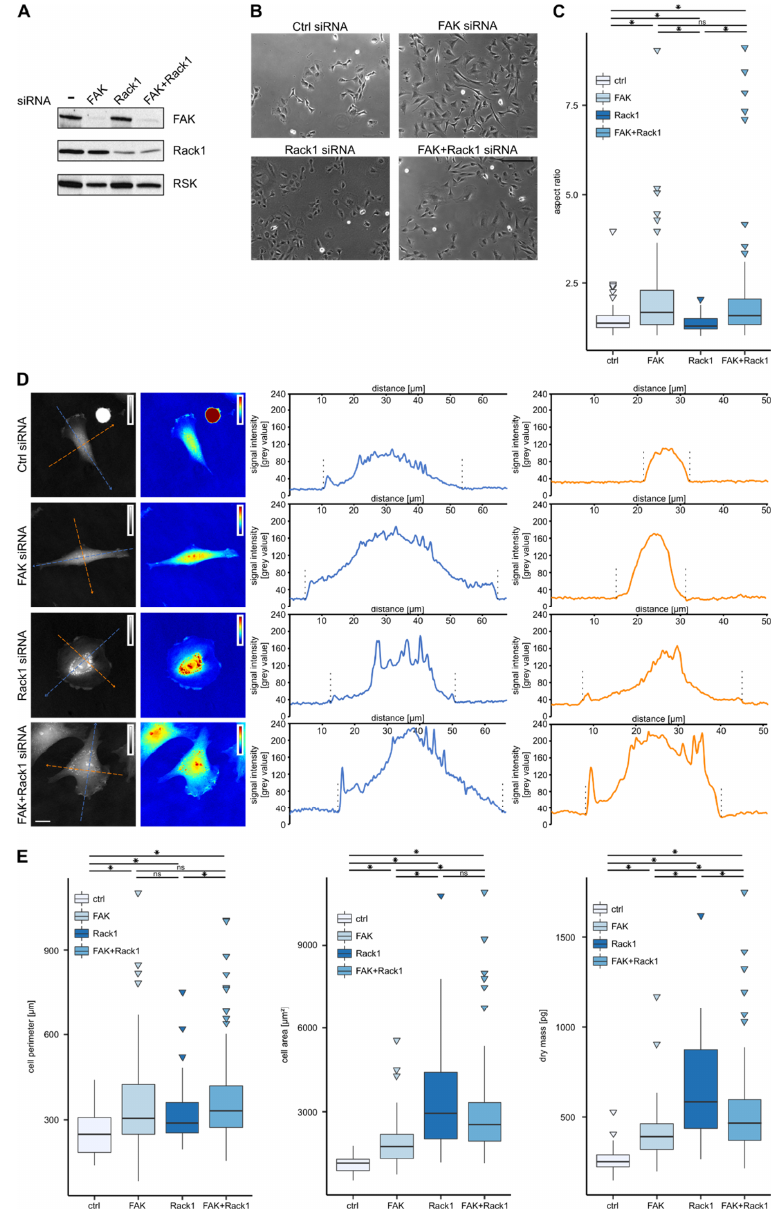
Figure 2. Depletion of FAK and Rack1 triggers two distinct phenotypes depicted by CCHM. ( A ) Expression levels of FAK and Rack1 proteins in control and siRNA treated cells were determined. RSK was used as the loading control. ( B ) Conventional phase contrast microscopy images of the control, FAK, Rack1 and FAK + Rack1 siRNA treated cells are shown. ( C ) Quantification of the cell shape of the control, FAK-, Rack1-, and FAK + Rack1-depleted cells using the aspect ratio (the ratio of the cell length to cell width) is plotted. The representative result of one out of three biological replicates is shown ( n > 50). ( D ) Grayscale or pseudo-colored quantitative phase images of the control, FAK, Rack1, and FAK + Rack1 siRNA-treated cells are provided (insets represent the signal intensity scale). The graphs show a distribution of signal intensities (i.e., cell dry mass) of corresponding diagonal (blue) and cross (orange) sections. Cell borders are indicated by dashed lines. ( E ) Quantifications of the cell perimeter, cell area, and cell dry mass of the control, FAK, Rack1, and FAK + Rack1 siRNA-treated cells are plotted. The representative result of one out of two biological replicates is shown (n > 50). * p < 0.05. Scale bars 200 µ m ( B ), 10 µ m ( D